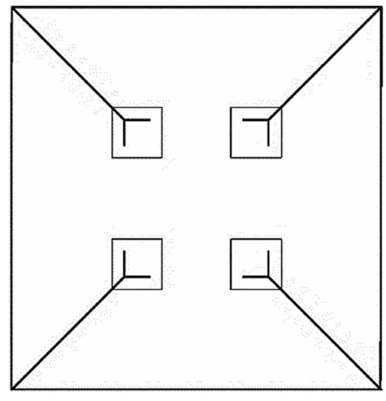
Figure 15. MT4 and MT5 layout with ground ring. Table 20. Countermeasure 4: improvement of the lightning performance for different soil resistivity